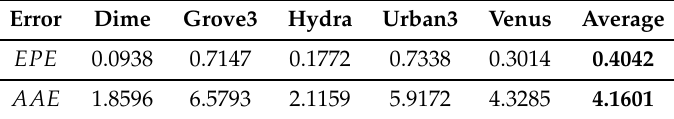
Average EPE and AAE obtained by the maximum gradient location strategy in